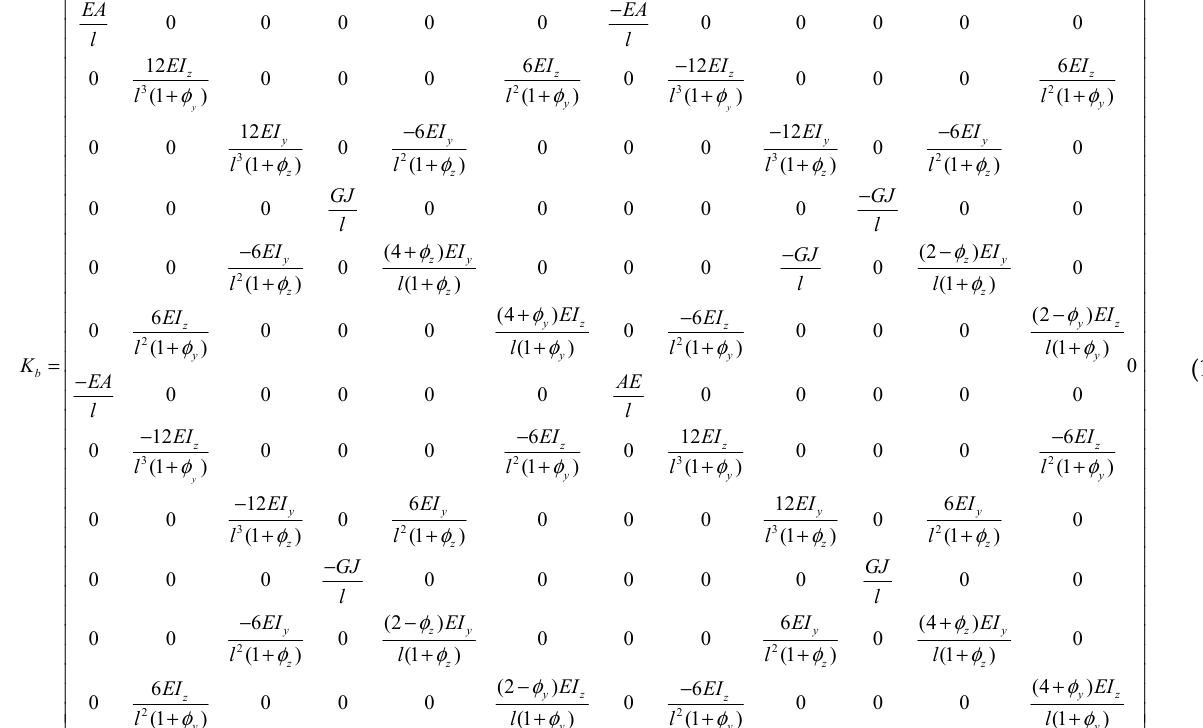
conventional one denoted as No.